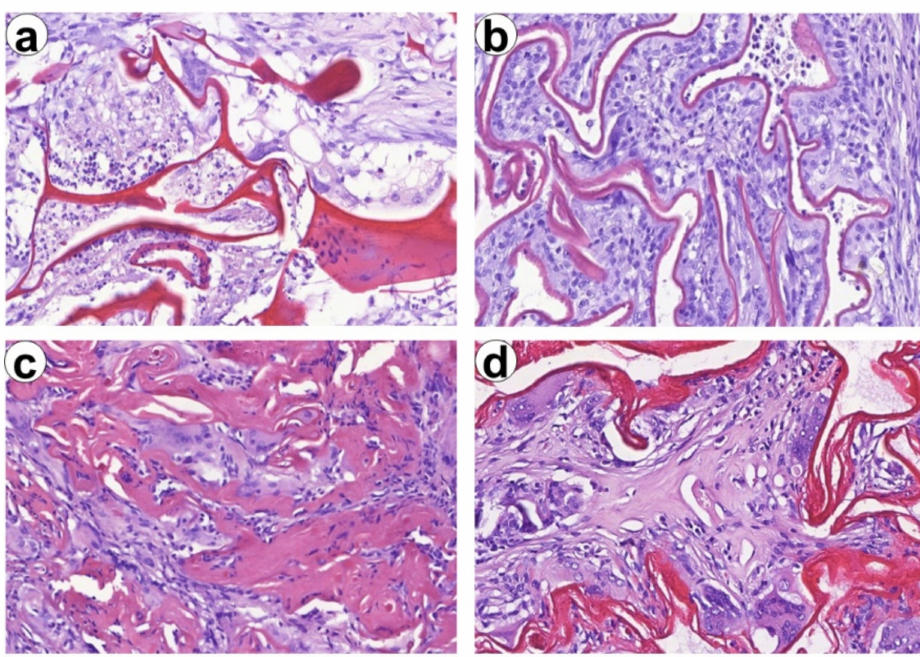
Figure 8. Differences in Ch-based materials degradation and biocompatibility at different terms after surgery. ( a , b ) Hemostatic materials (ChSp and ChEsM, respectively) at early stages after surgery (after one week). ( c , d ) Same materials in 2 months after liver trauma, Magnification 400 × . Inflammation in the capsule was associated with M1 and M2 macrophages